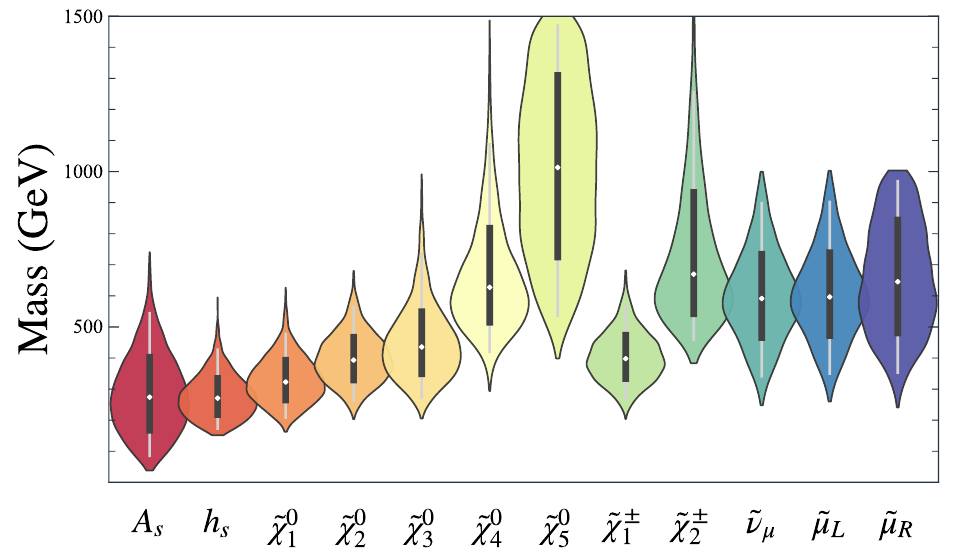
Figure 9 . Same as figure 3, but for the samples surviving the LHC